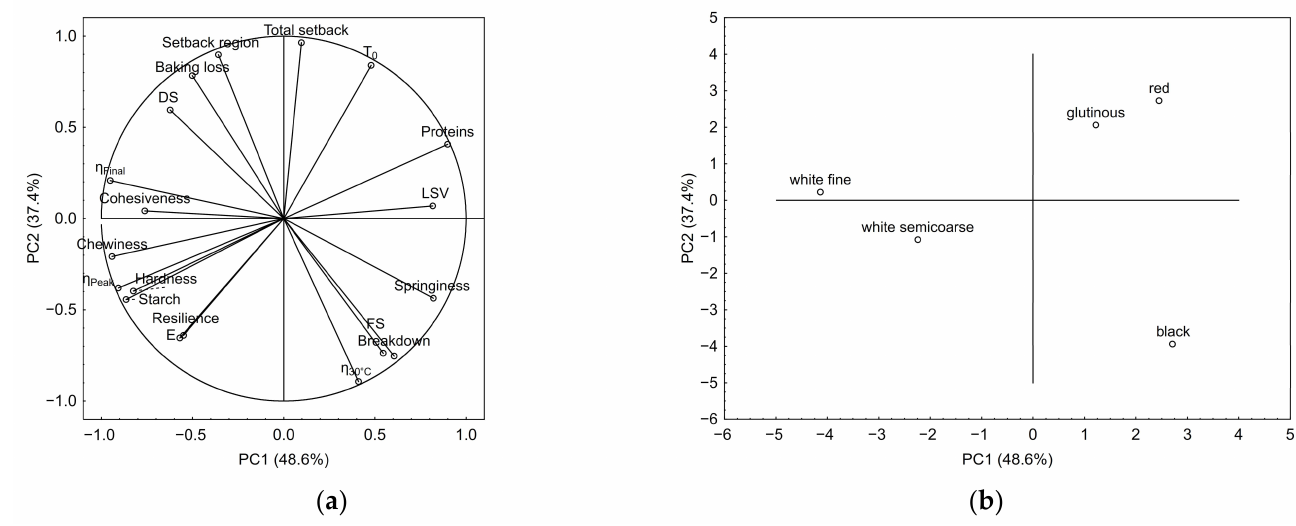
Figure 3. Principal component analysis: ( a ) score plot for the first and second principal components; ( b ) loading plot for the first and second principal